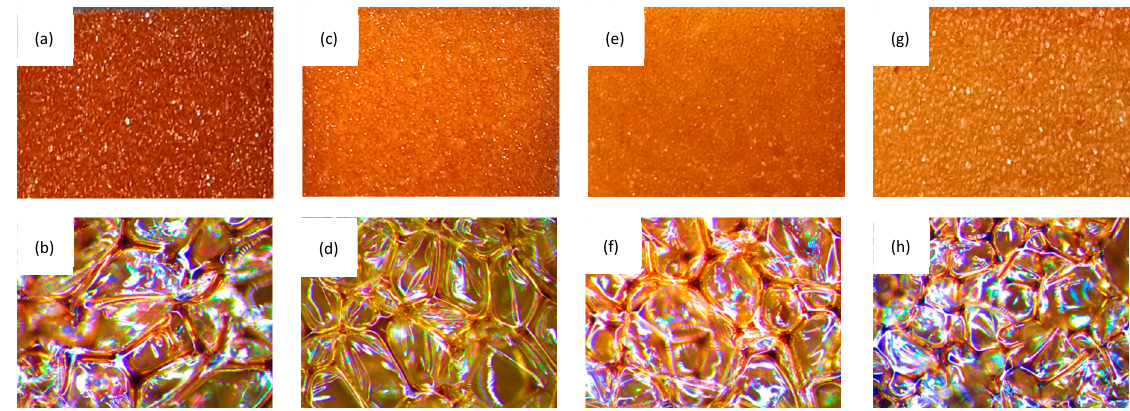
Figure 10. Optical images of ( a , b ) PUR_NEAT; ( c , d ) PUR_C_1; ( e , f ) PUR_C_2; ( g , h ) PUR_C_5.